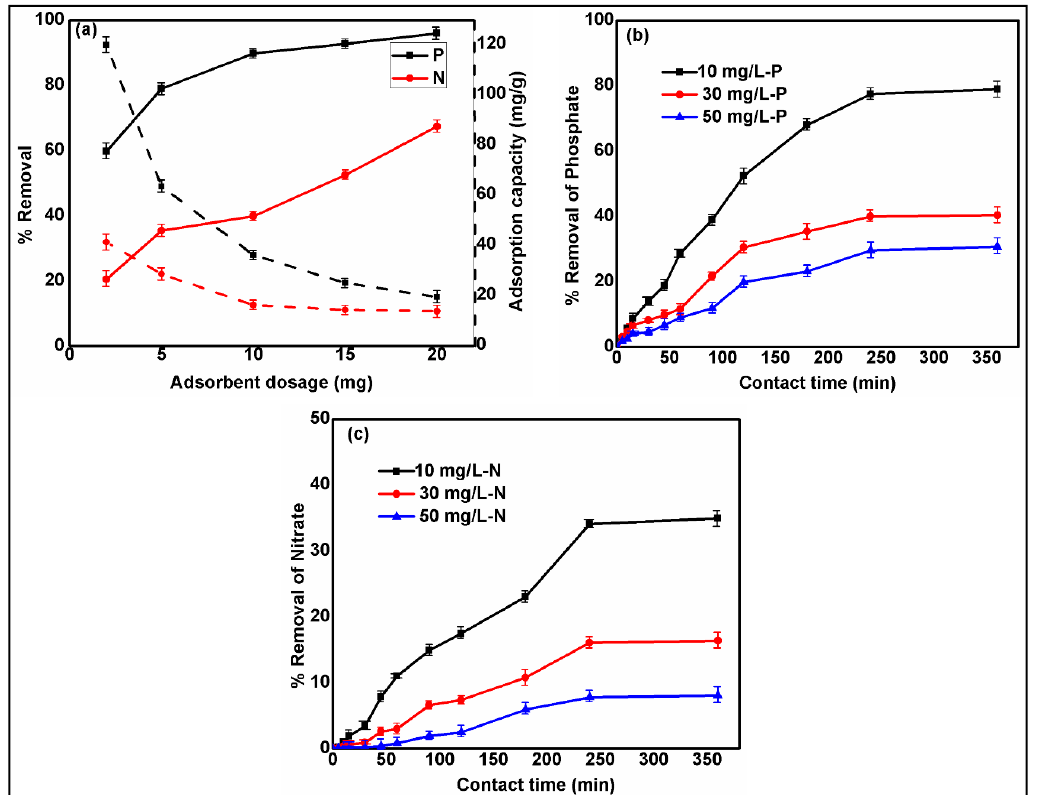
Figure 5. Effect of SBAC 100 MgFe composite dosage on nitrate and phosphate removals ( a ). Effect of contact time on the removal of phosphate ( b ) and nitrate ( c ) using SBAC 100 MgFe composite.